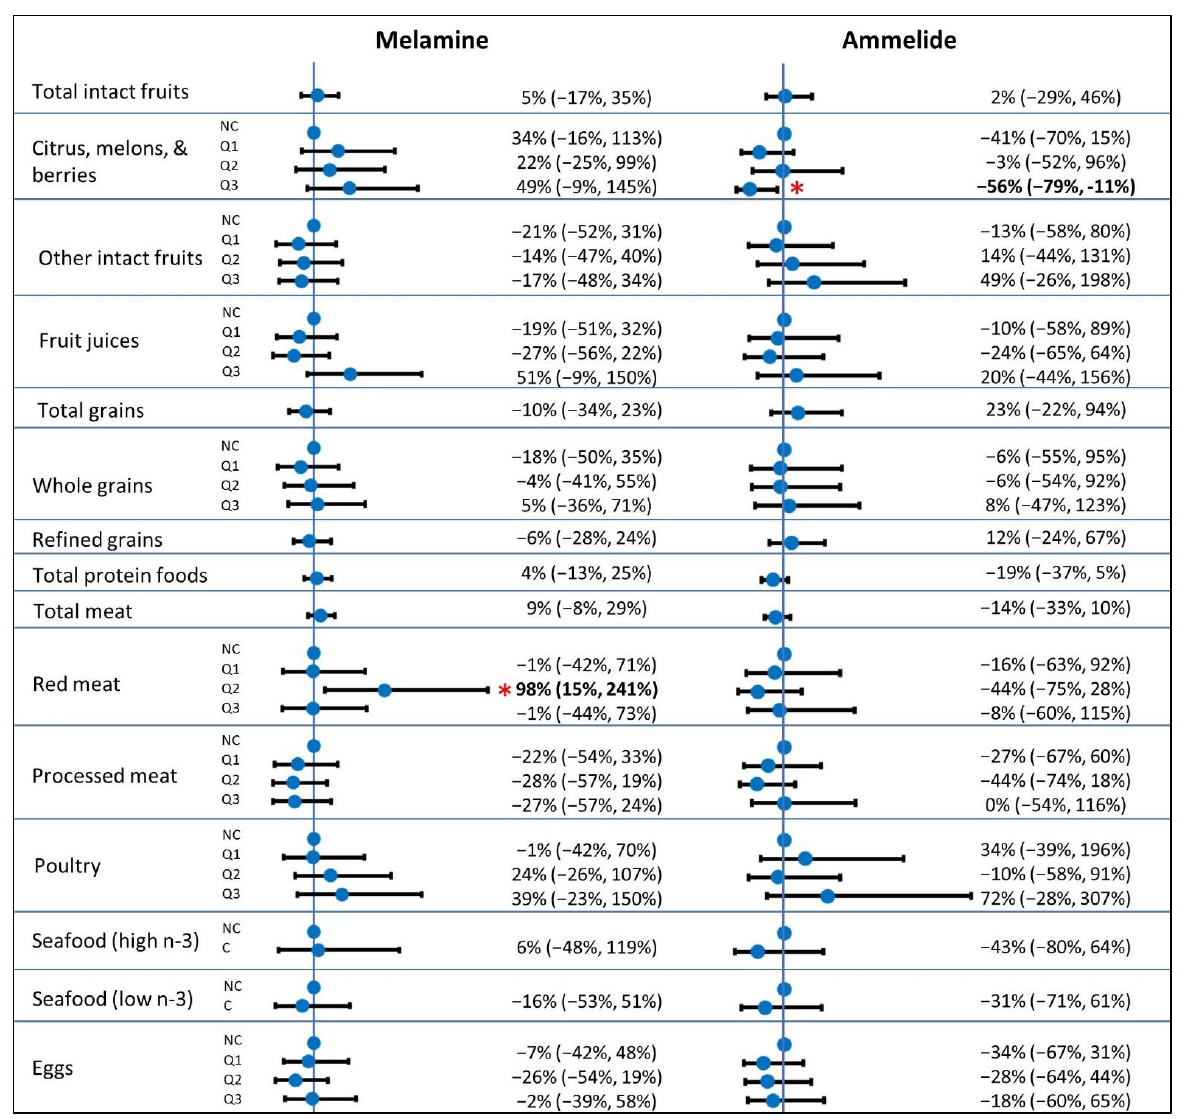
Figure 1. Estimated percentage difference (with 95% CI) in urinary melamine or ammelide concen- trations for a 50% increase in consumption (continuous dietary variables) or in comparison to the reference group (categorical dietary variables) for fruits, grains, and protein foods. Estimates with p -values < 0.05 shown in bold text with asterisk. Models adjusted for age, sex, child race and ethnicity (Non-Hispanic White, Hispanic White, multiple races, other), household income (<45 k, 45–75 k, 75–100 k, 100–150 k, >150 k), maternal education (<college grad, college grad, advanced degree), BMI for age percentile (continuous), pesticide use in home over the last year (yes, no), and site (Seattle, Yakima); Abbreviations: NC, non-consumer; C, consumer; Q1–Q3, quantiles